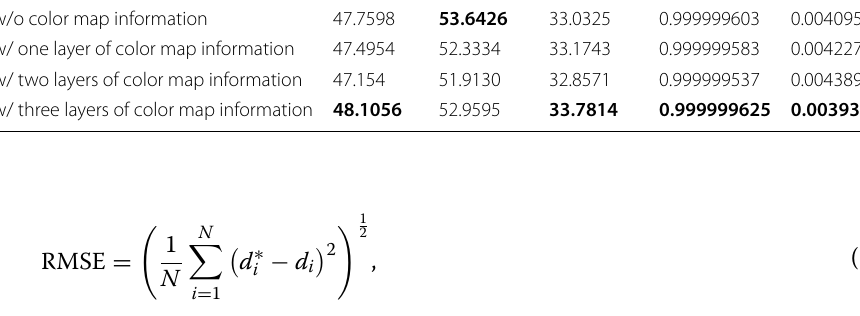
Table 3 Evaluation results of reducing layers of color map features Measures